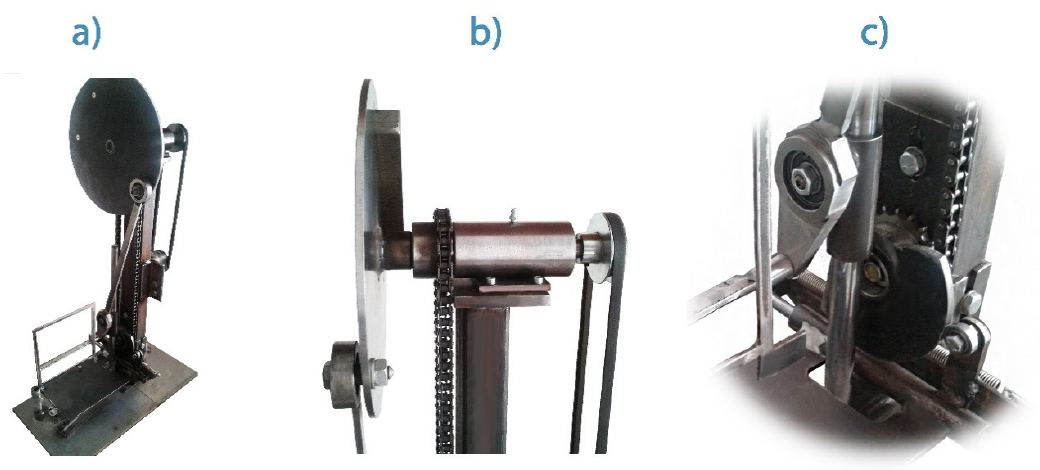
Figure 3. Photo about contact drawing device in full view ( a ), eccentric drive disc ( b ), guiding column, slider and control disc ( c ).